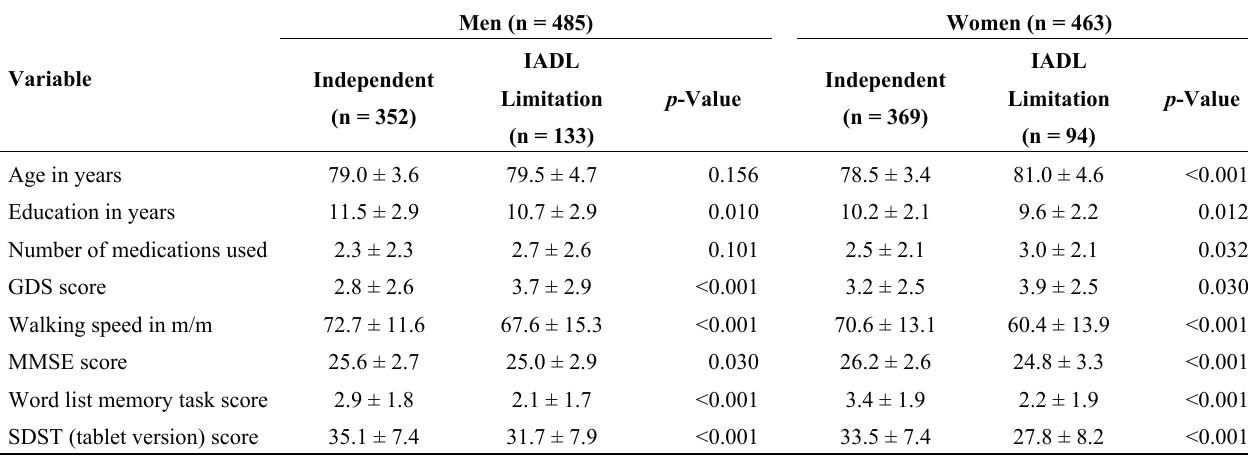
Table 3. Comparison of baseline characteristics between participants with and without self-reported IADL limitation in the 15-month follow-up survey (n =